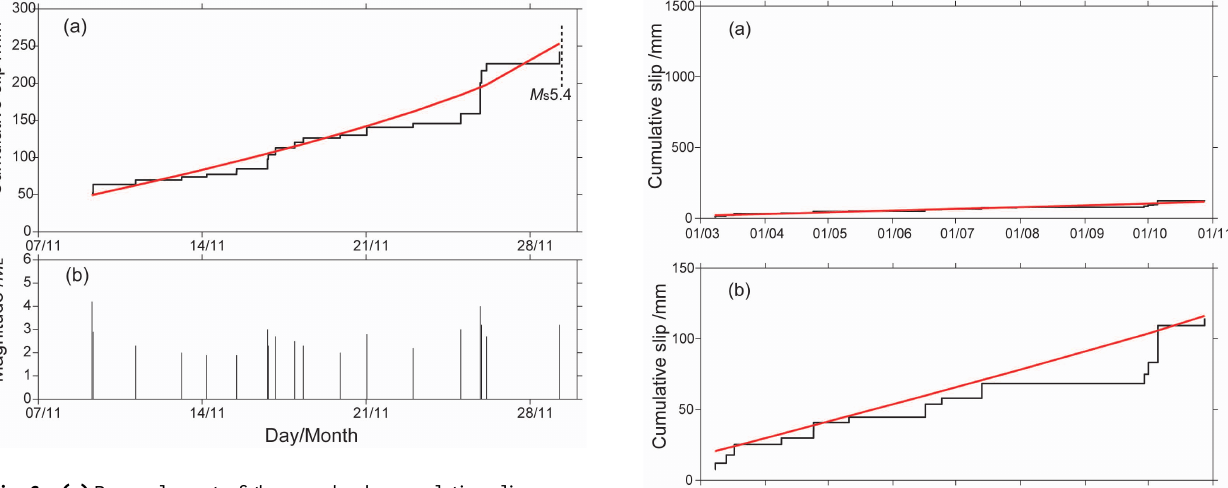
Fig. 6. (a) Power-law fit of the pre-shock cumulative slip curve, for the “repeaters” within the Xiuyan 52-plet, occurred before the Xiuyan earthquake. The power-law curve is represented by the red line, showing the accelerating-like behavior. This figure is a fur- ther zooming-in of Fig. 5a and b. (b) Magnitude-time plot of the “repeating earthquake sequence” in (a) . It is somehow similar to foreshock activities, but the spatial range is limited to the range of the “multiplet”.